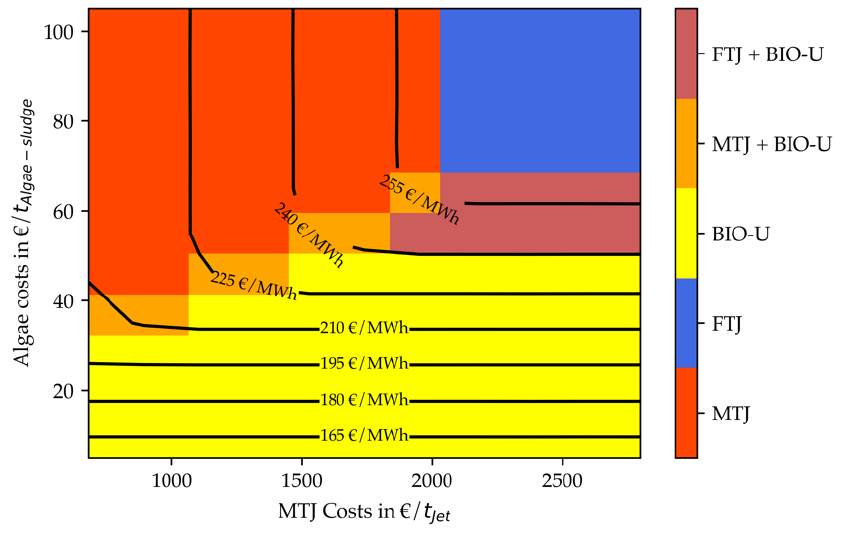
Figure 18. Net production costs (contour lines) and technology choice (heatmap) of optimized renewable refinery depending on algae costs and MTJ costs in scenario 4.